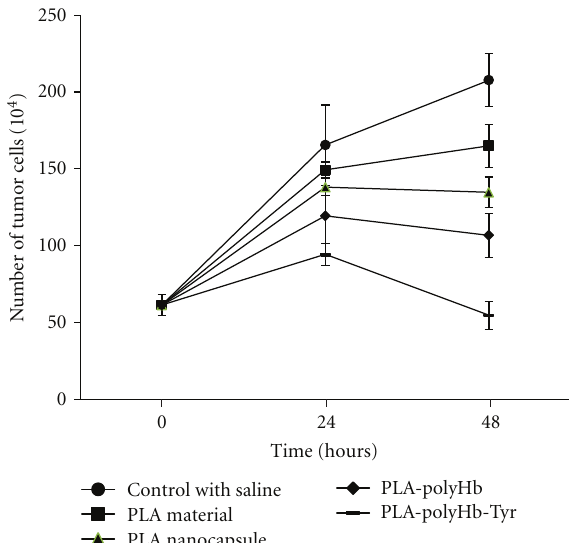
Figure 9: The e ff ects of PLA nanocapsule [polyHb-tyr] and the functions of its components on the attachment of B16F10 melanoma cells.